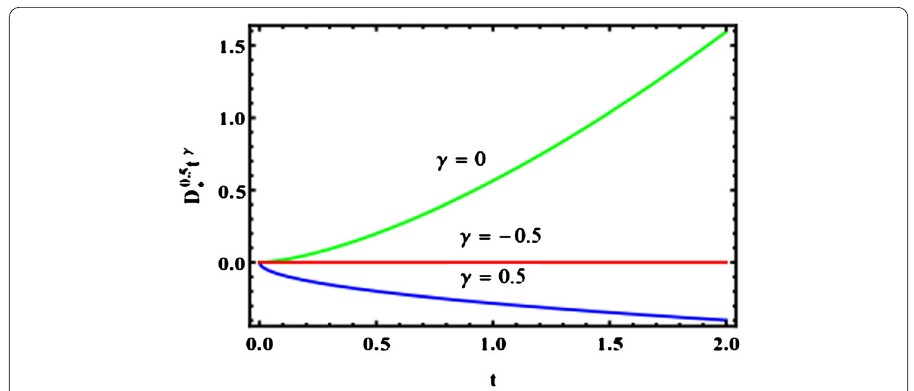
Figure 1 The Riemann–Liouville fractional derivative D 0.5 ∗ t γ for different values of